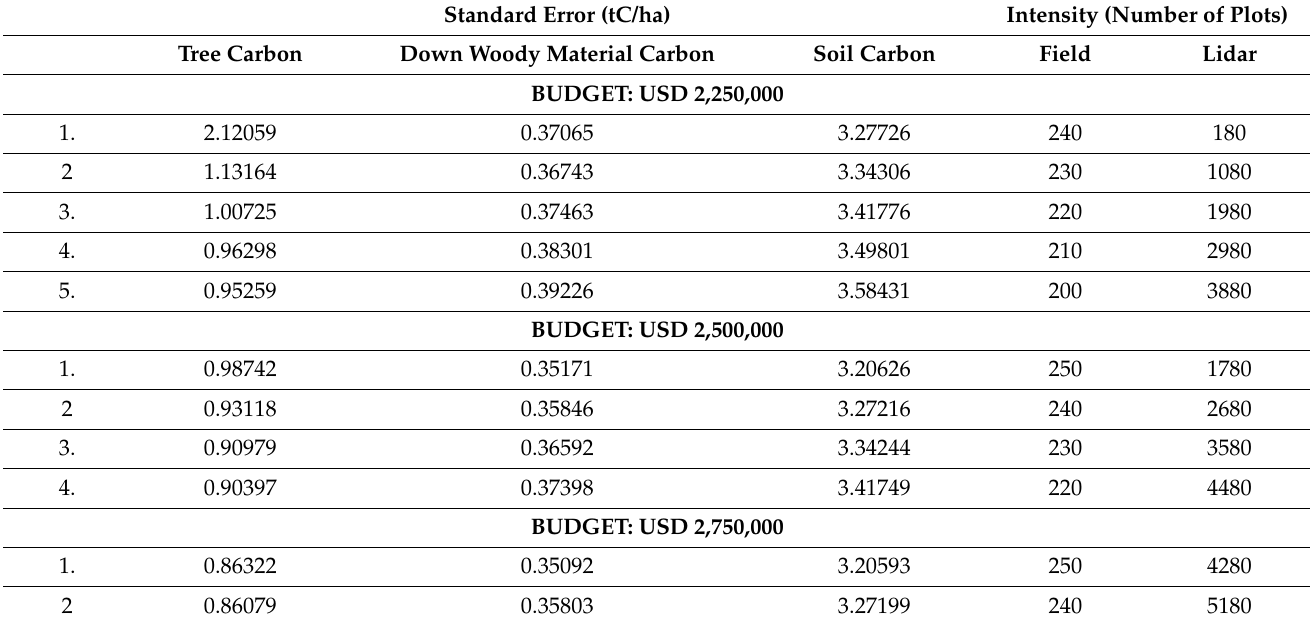
Table 2. Pareto optimal sampling schemes and their associated standard errors using parameter estimates based on observed data with a budget of USD 2.25 M, USD 2.5 M, and USD 2.75